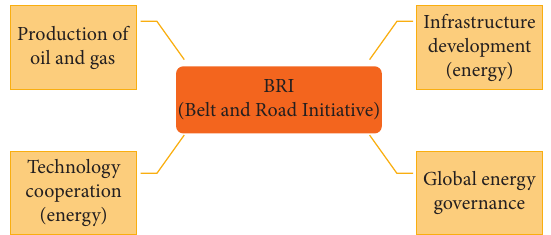
Figure 7: Energy cooperation under Belt and Road Initiative (BRI)